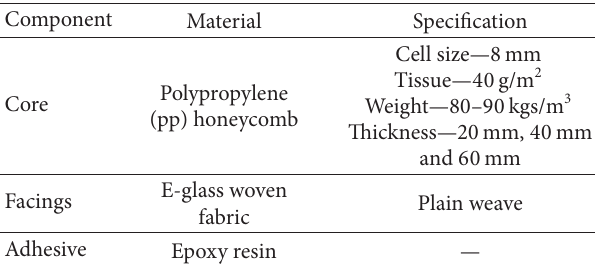
Table 1: Specification of the